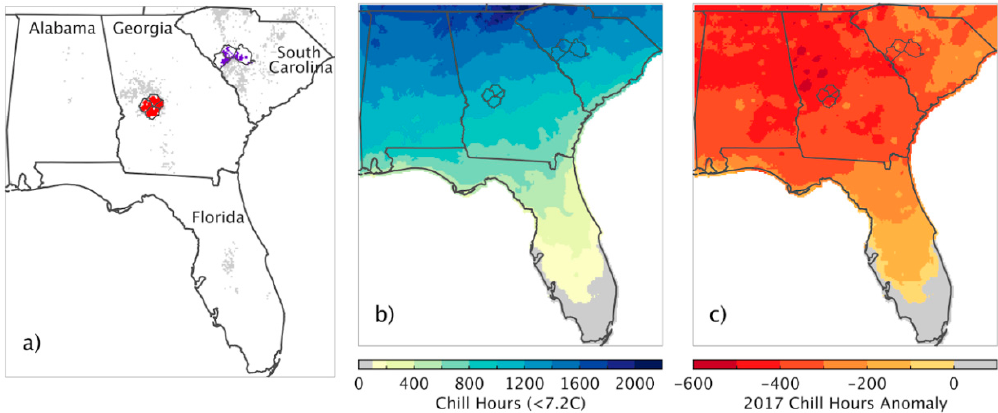
Figure 1. ( a ) The southeastern US study area. 4-km cells with > 0.01% peach density are highlighted in grey. Georgia and South Carolina peach-growing counties examined explicitly in this study are outlined in grey and those cells with > 0.01% peach density within these counties are highlighted in red (Georgia) and purple (South Carolina). ( b ) The average annual number of chill hours for the 1981–2017 observed period. Areas with < 100 chill hours are masked in grey. ( c ) The winter chill accumulation anomaly in 2017 compared to the 1981–2017 average. Areas masked in grey as in ( b ).